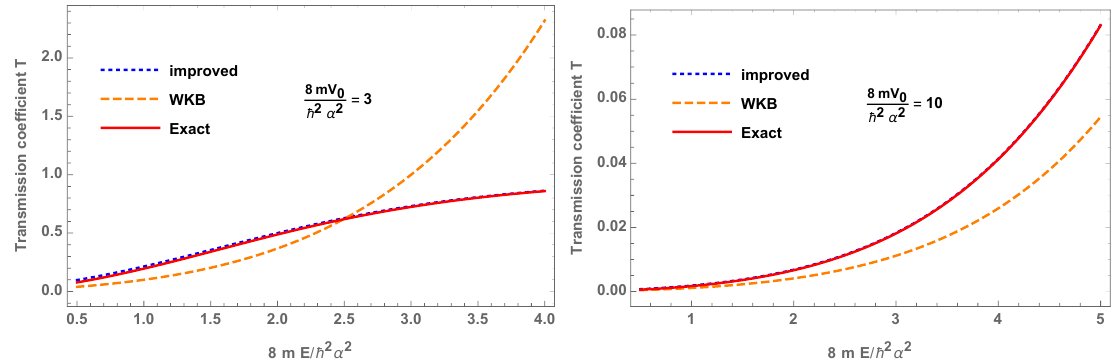
Figure 1. Comparison among the exact transmission coefficient T , WKB transmission coefficient (56), and our “improved" transmission coefficient